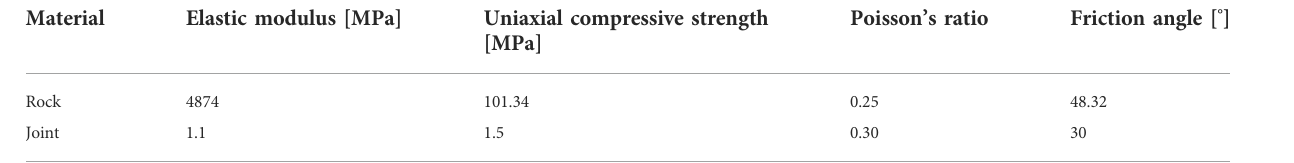
TABLE 2 Mechanical parameters of the rock (Mahdevari et al., 2020).